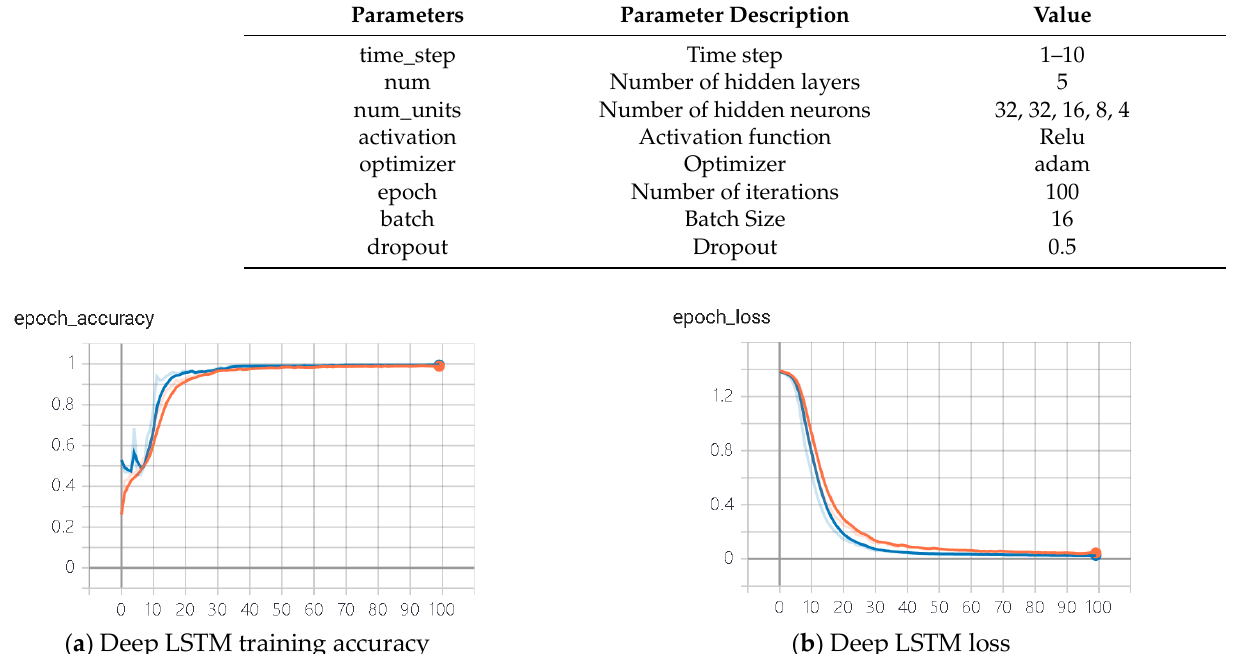
Figure 11. Deep LSTM training parameters diagram.